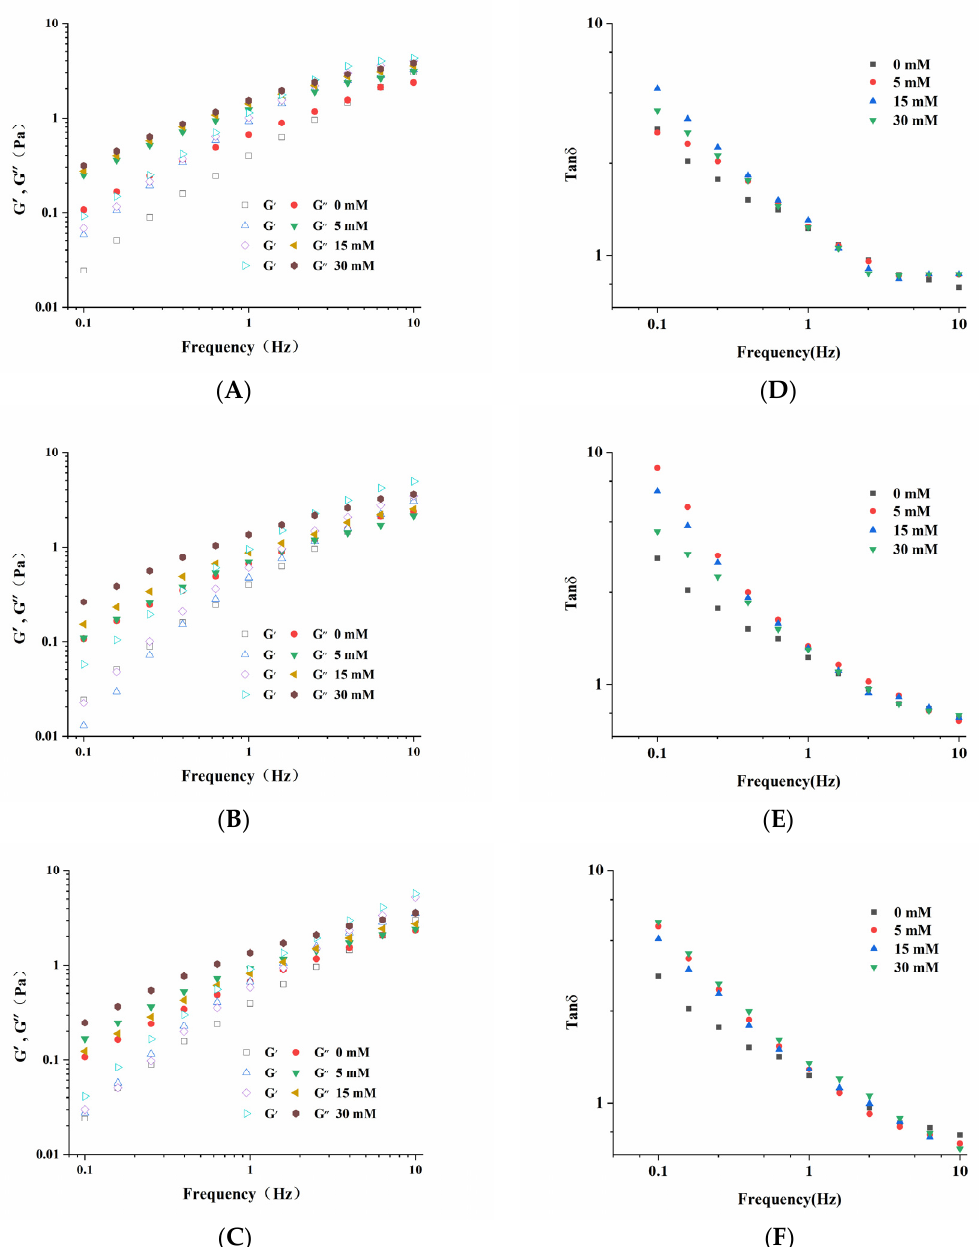
Figure 4. Viscoelastic behavior of the low methoxyl pectin/sodium caseinate (LMP/CAS) complex. Storage modulus (G’) and loss modulus (G”) of Na + –LMP/CAS ( A ), K + –LMP/CAS ( B ), and Ca 2+ –LMP/CAS ( C ). Loss tangent of Na + –LMP/CAS ( D ), K + –LMP/CAS ( E ), and Ca 2+ –LMP/CAS ( F ). ( D ), K + –LMP/CAS ( E ), and Ca 2+ –LMP/CAS ( F